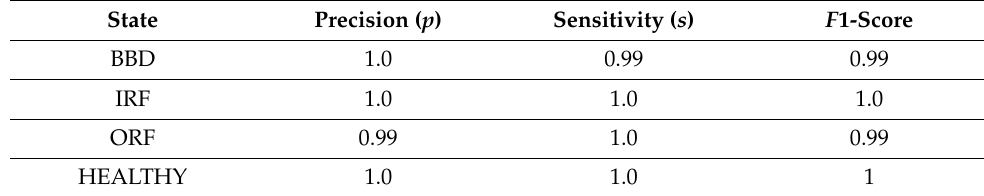
Table 2. Performance metrics of the proposed